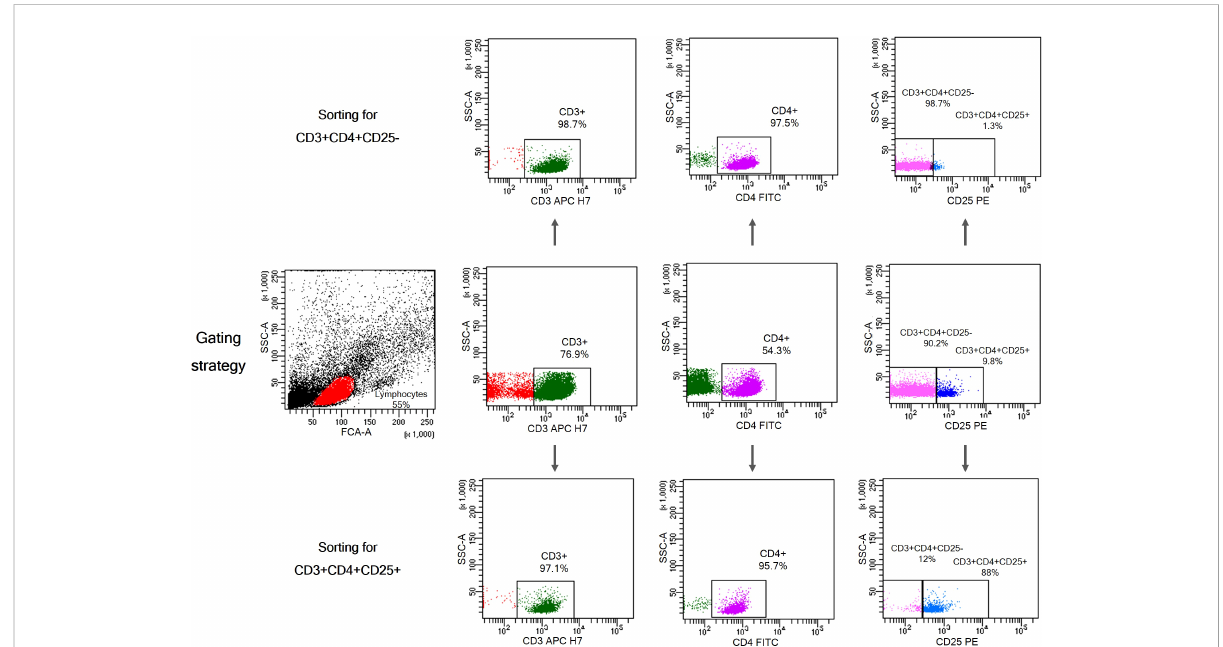
FIGURE 2 Gating strategy for isolation of CD3+CD4+CD25+ T cells and CD3+CD4+CD25- T cells from PBMCs. Characteristic dot plots showing purity after cell sorting using BD FACS Aria III Cell Sorter.